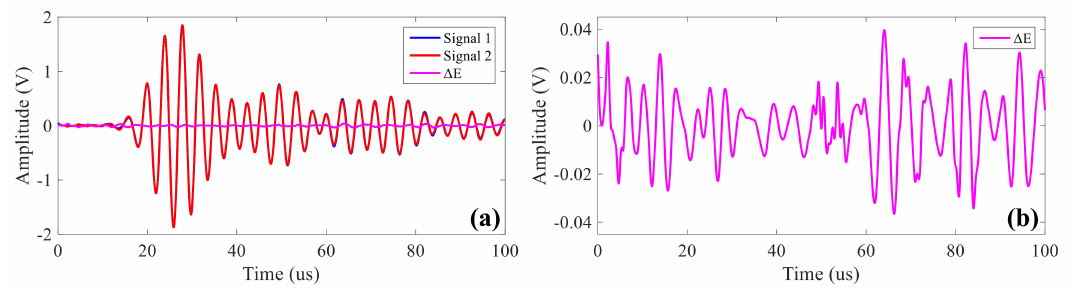
Figure 13. System repeatability test at the frequency of 250 khz actuation signals: ( a ) comparison after